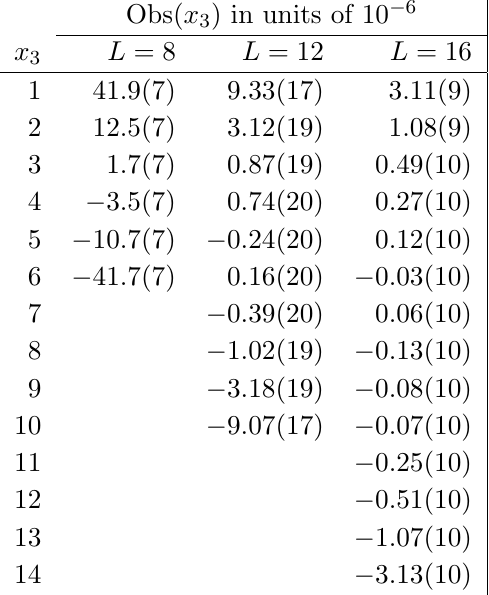
Table 1 . Results of Monte Carlo measurements with statistical